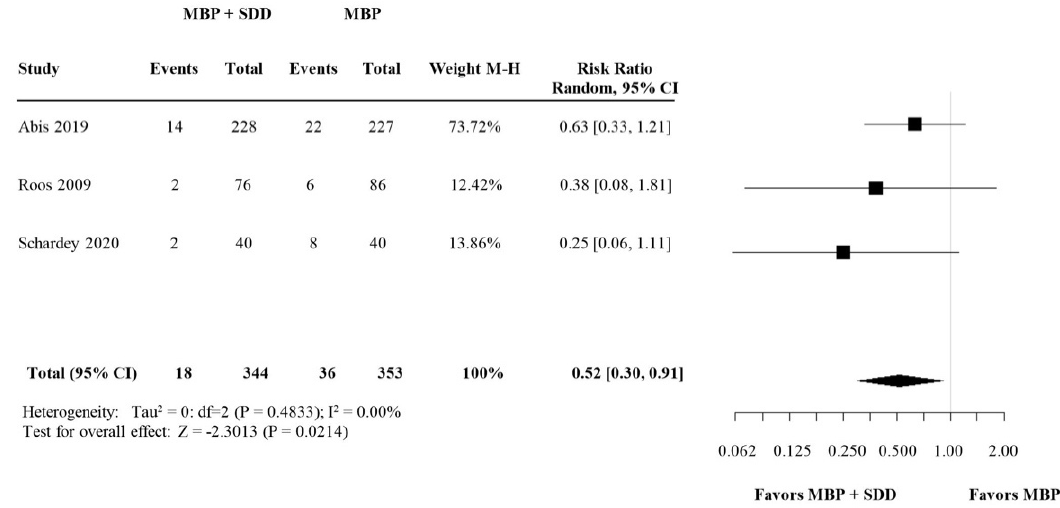
Figure 4. Forest plot comparing anastomotic leakage rate for patients receiving SDD (selective decontamination of the digestive tract is selective OAB targeting only the specific aerobe, Gram-negative bacteria) in addition to MBP and i.v. antibiotic prophylaxis versus MBP with i.v. antibiotic prophylaxis. A random effects model was used to perform the meta-analysis and risk ratios are quoted including 95% confidence intervals.